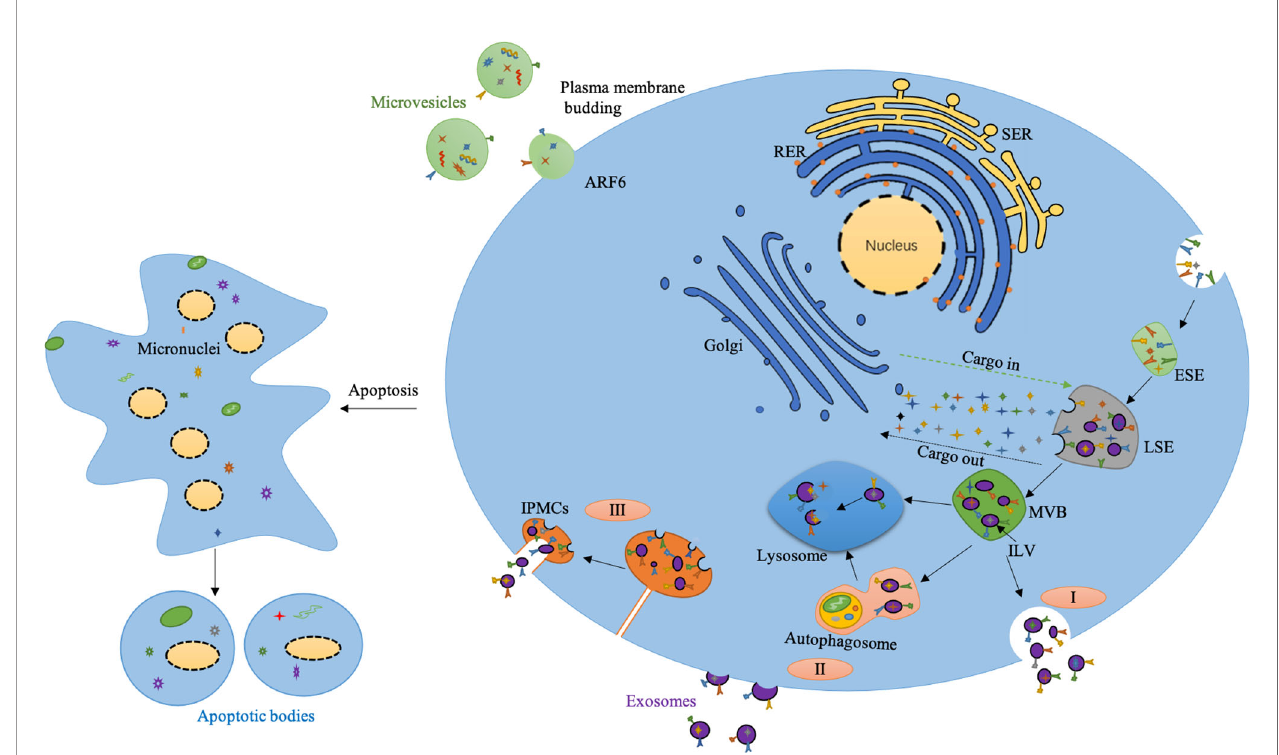
FIGURE 1 | Biogenesis of extracellular vesicles. I) The classical pathway of exosomes biogenesis. II) Exosomes are released directly from the plasma membrane by budding. III) Exosomes released by budding at intracellular plasma membrane – connected compartments (IPMCS). The neck channel of the IPMCS becomes wider, the neck restraint is released, and the exosomes are released outside. Micro-vesicles are produced by plasma membrane budding mediated by ARF6. Apoptotic bodies are produced from apoptotic cells. SER, Smooth endoplasmic reticulum; RER, Rough endoplasmic reticulum; ESE, Early sorting endosome; LSE, Late sorting endosome; MVB, Multivesicular body; ILV, Intraluminal